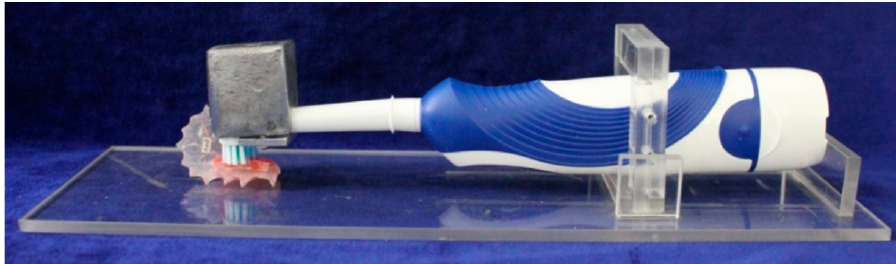
Figure 2- Illustrative image of the device used for brushing